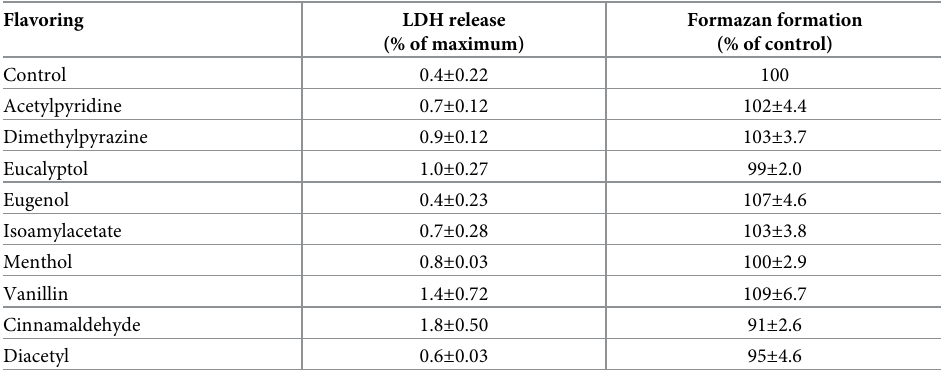
Table 2. Effects of flavorings on endothelial cell viability. Flavoring LDH release Formazan formation (% of maximum) (% of control) Control 0.4 ± 0.22 100 Acetylpyridine 0.7 ± 0.12 102 ± 4.4 Dimethylpyrazine 0.9 ± 0.12 103 ± 3.7 Eucalyptol 1.0 ± 0.27 99 ± 2.0 Eugenol 0.4 ± 0.23 107 ± 4.6 Isoamylacetate 0.7 ± 0.28 103 ± 3.8 Menthol 0.8 ± 0.03 100 ± 2.9 Vanillin 1.4 ± 0.72 109 ± 6.7 Cinnamaldehyde 1.8 ± 0.50 91 ± 2.6 Diacetyl 0.6 ± 0.03 95 ±